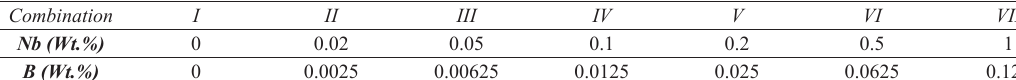
Table 2. Nb-B level range added to Al-Si-Fe